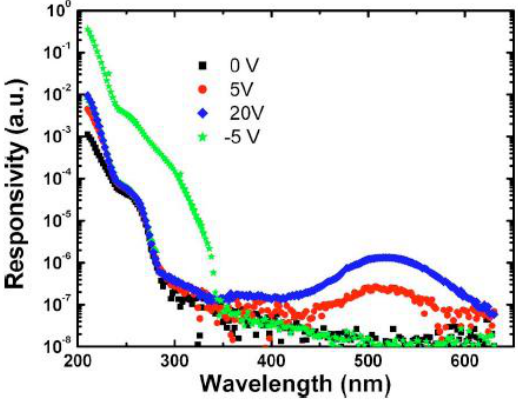
Figure 14. Spectral response of a Schottky detector with a semitransparent dotted Schottky contact at various biases (reprinted from Reference